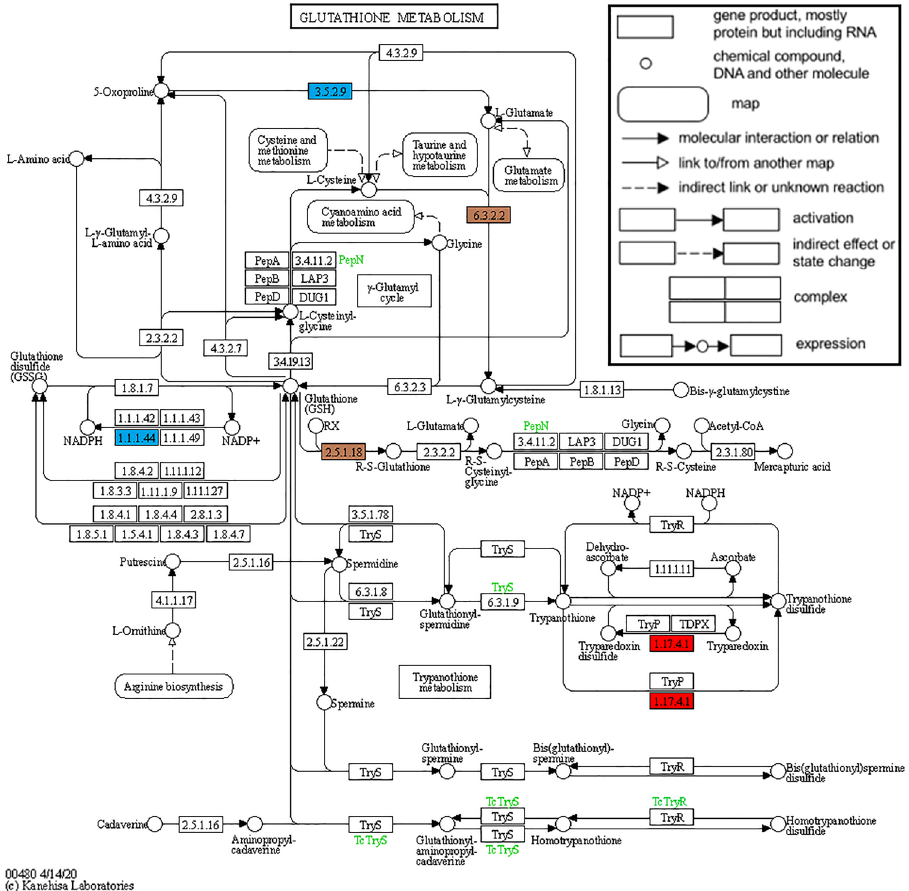
Figure 8. KEGG representation of the Glutathione metabolism (map00480). The upregulated genes and proteins in the resistant cultivar, Gladiator, were mapped to the KEGG glutathione metabolism. KEGG genes products found affected through RNA-seq (red) and proteome analysis (blue) are pinpointed in the figure. The brown squares are representing the genes/proteins that were upregulated in both RNA-seq and